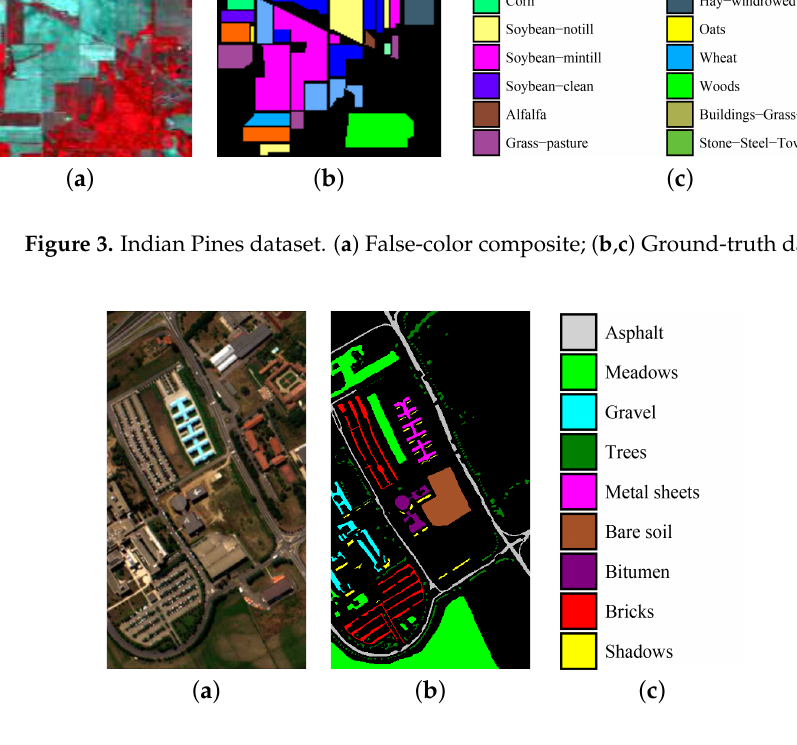
Figure 4. University of Pavia image. ( a ) False-color composite; ( b , c ) Ground-truth data.